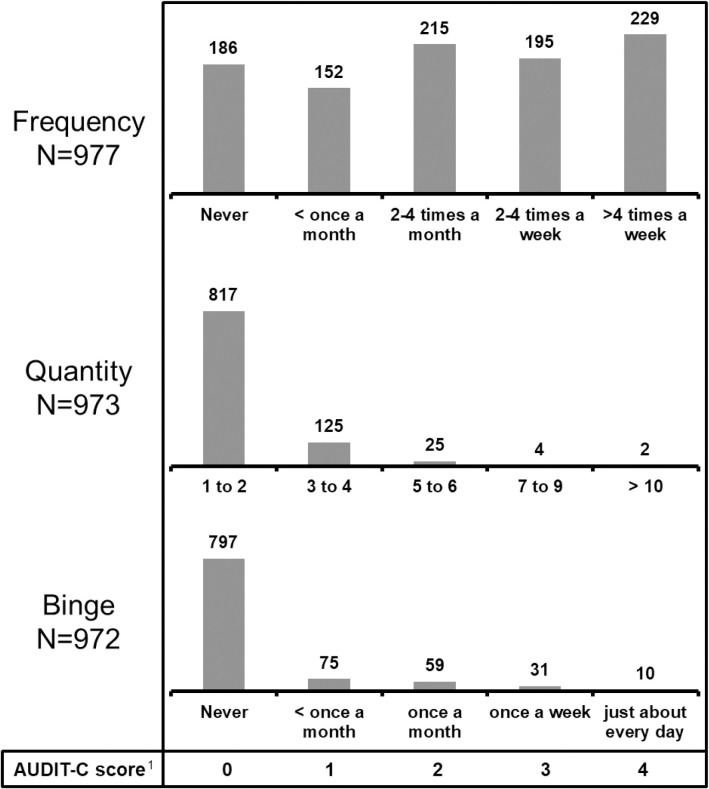
Distribution of alcohol consumption frequency and quantity and binge drinking among 981 study participants.The numbers above each bar in the three bar plots represent the number of participants with each score. 1The numbers 0 to 4 are the scores assigned to each possible response in the AUDIT-C score questionnaire. The response options are written below each bar for the three categories of frequency, quantity and binge. Taking the category ‘frequency’ as an example, ‘never’ scores 0, while ‘>4 times a week’ scores 4.